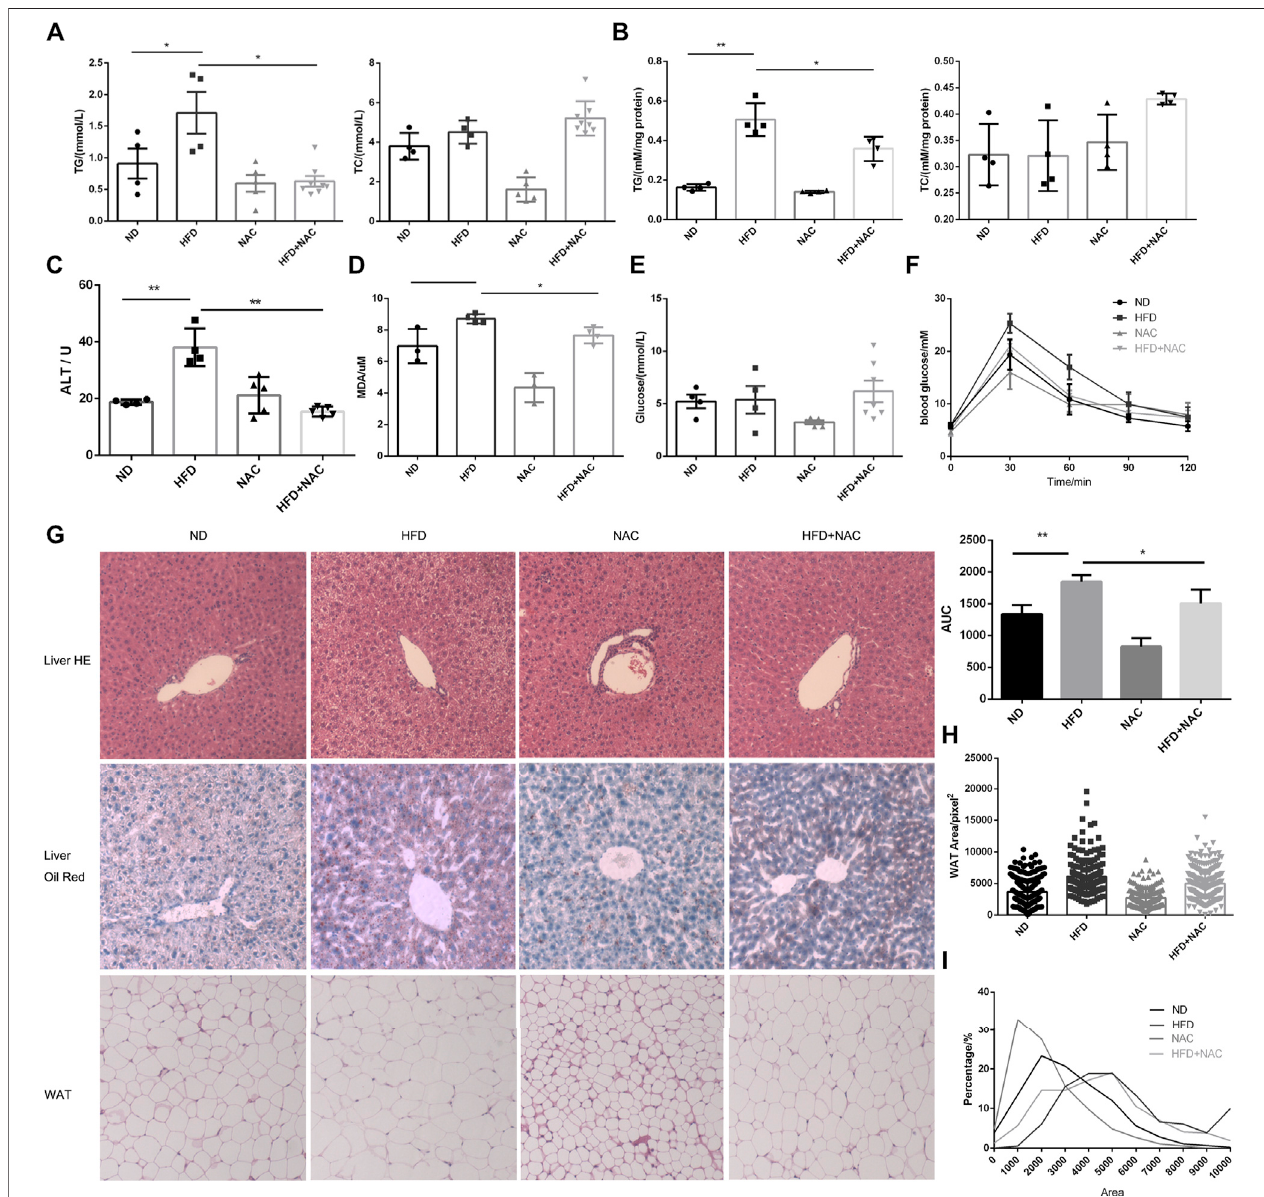
FIGURE 1 | NAC treatment could alleviate HFD-induced NAFLD in vivo . (A) Concentration of TG and TC in serum of mice; (B) concentration of TG and TC in mice hepatic tissues,whichwasadjusted toprotein concentration; (C) serum ALTlevelofmice; (D) concentrationofMDAinserum ofmice; (E) fasted blood glucose level; (F) bloodglucoseconcentrationofmiceat0,30,60,90,and120 minafteroralglucosegavage,andtheundercurveareawascalculated; (G) HEstainingandoilredstaining ofsectionoflivetissueandHEstainingofmicewhiteadiposetissue(WAT); (H) cross-sectionareaofwhiteadipocyteindifferentgroups; (I) percentageofadipocyte with different cross-section areas (* p < 0.05, ** p < 0.01, and **** p < 0.0001; all the data signi fi cance was analyzed by ANOVA).